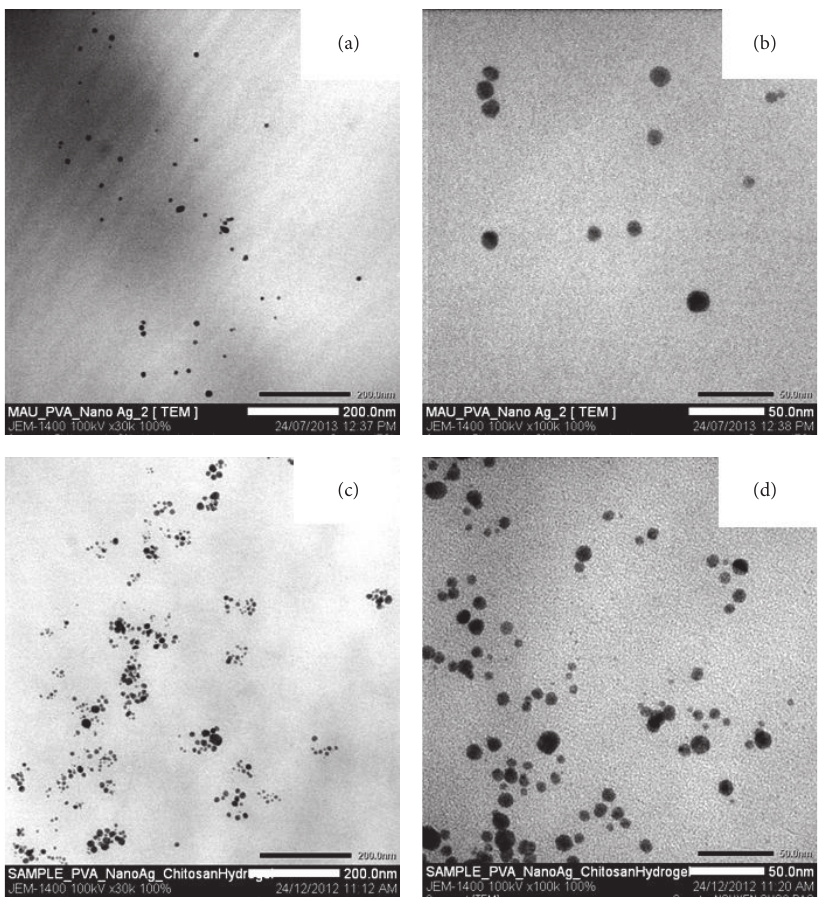
Figure 2: TEM images of CPA 0.5 (a and b) and CPA 1 (c and d) at 30 k and 100 k magnification, respectively.